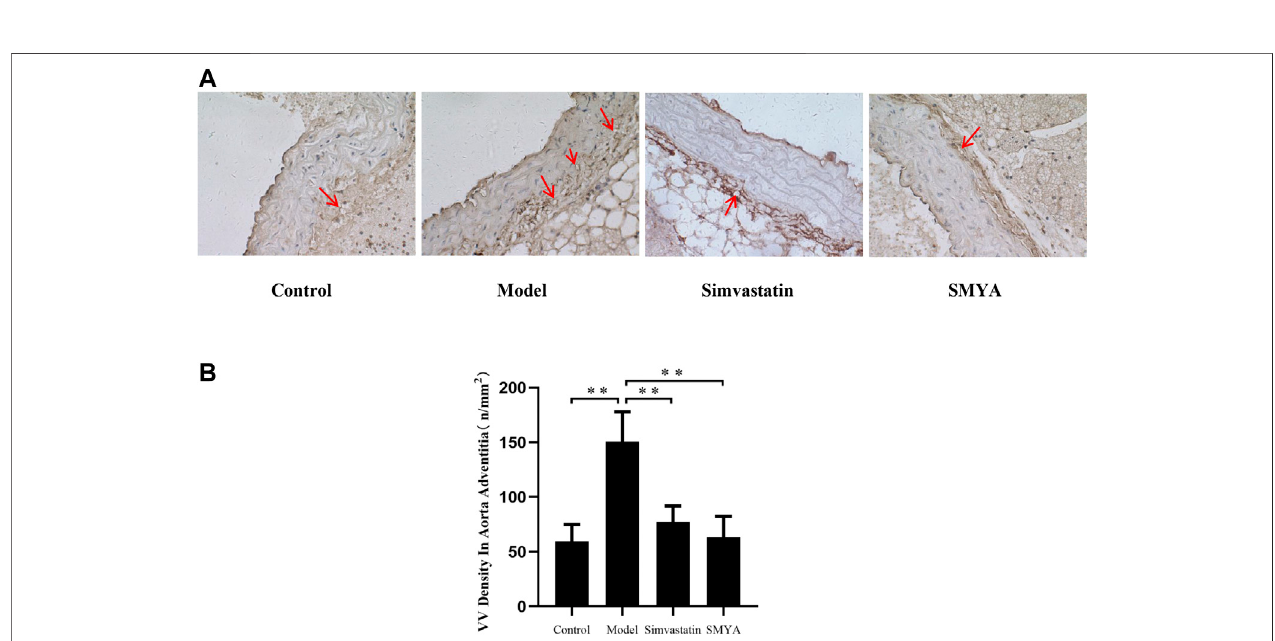
FIGURE 5 | Effect of SMYA on VV density in aorta adventitia. Immunohistochemical staining showed: compared with the control group, the density of CD34 positive stained VV in aorta adventitia was signi fi cantly increased in model group. Compared with the model group, the VV density in aorta adventitia was signi fi cantly decreased in both the simvastatin and SMYA groups. Red arrows marked the VV in aorta adventitia (Magni fi cation, × 400). (B) quantitative analysis of SMYA on VV density in aorta adventitia. Data are expressed as mean ± SD. **p < 0.01.